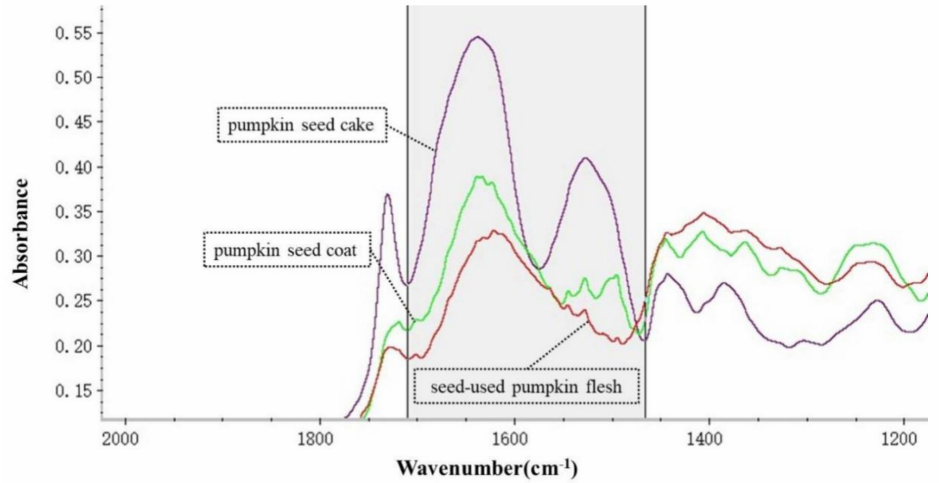
Figure 1. Typical molecular vibrational spectrum of different byproducts of seed-used pumpkin in the mid-IR within the protein amide